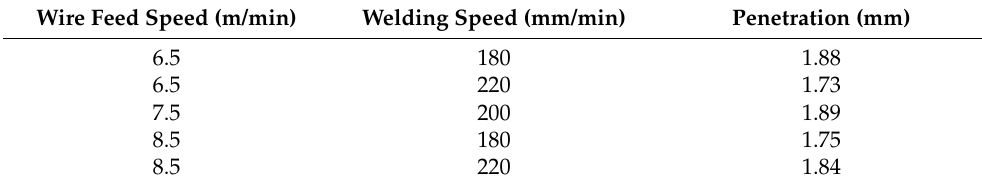
Figure 8. Size of heat-affected zones: ( a ) widths of HAZs obtained by the calculated models; ( b ) interaction of welding speed and wire feed speed on the width of the HAZs. Table 8. Penetration in a 12-millimeter-width groove.